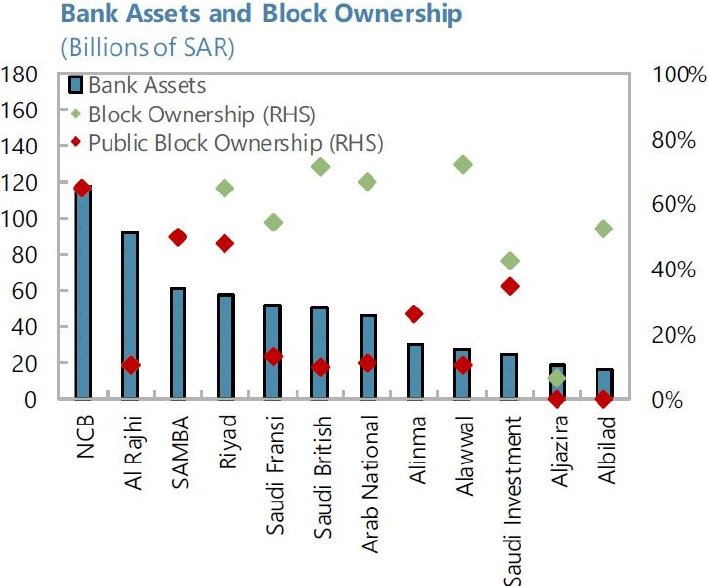
Figure 5. Block ownership is the fraction of shares held by all block owners (with stakes above 5 percent). Public block ownership is the fraction held by the PIF, GOSI, and PPA. Source IMF